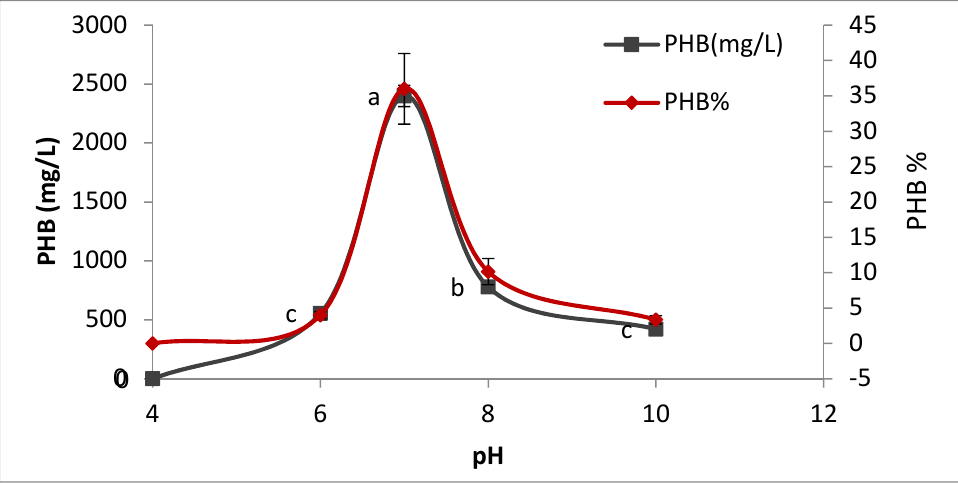
Figure 7. Effect of pH on the production of polyhydroxybutyrate (PHB) by Bacillus wiedmannii strain. The ANOVA test was carried out by using SPSS 21 comparisons among means ± SE standard error ( n = 3); different letters show significance at p = 0.05 level based on Duncan’s multiple range test.